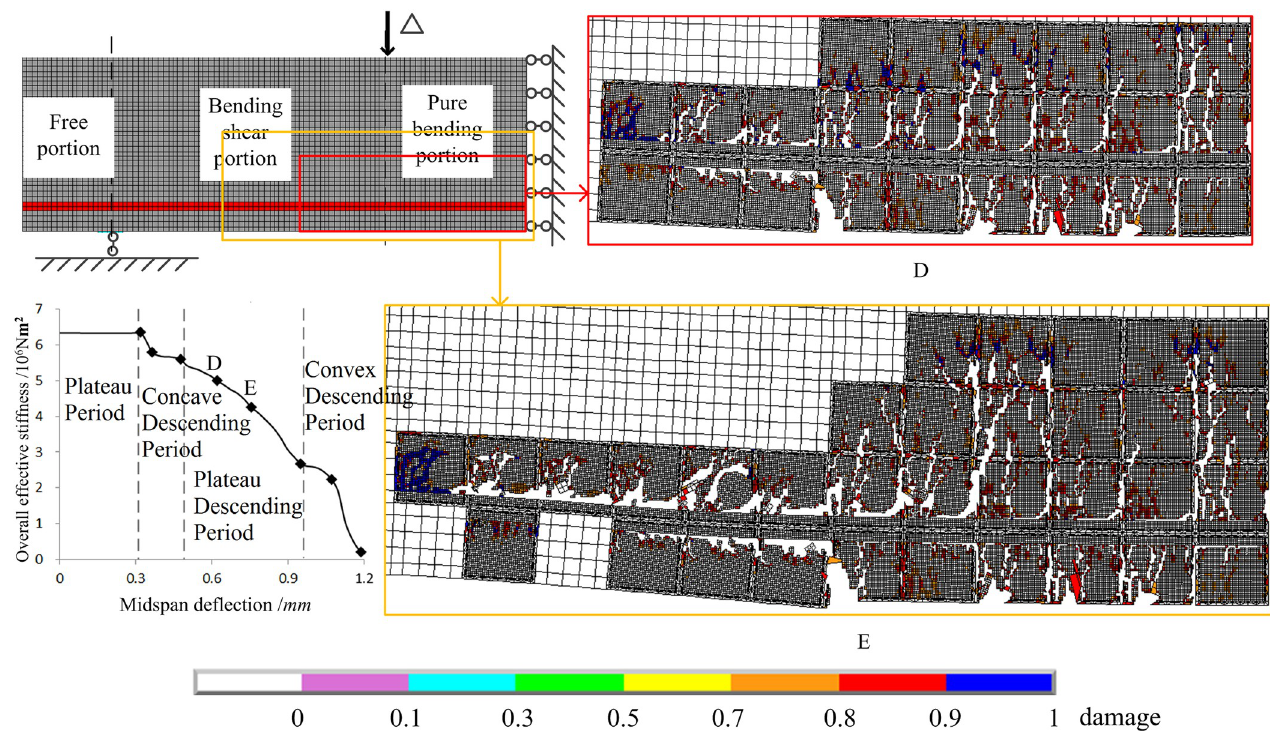
Fig 22. Two damage states in the steady descending portion of the overall effective stiffness. There are two damage states of D and E, which correspond to the points D and E that are located on steady descending period of the curve of overall effective